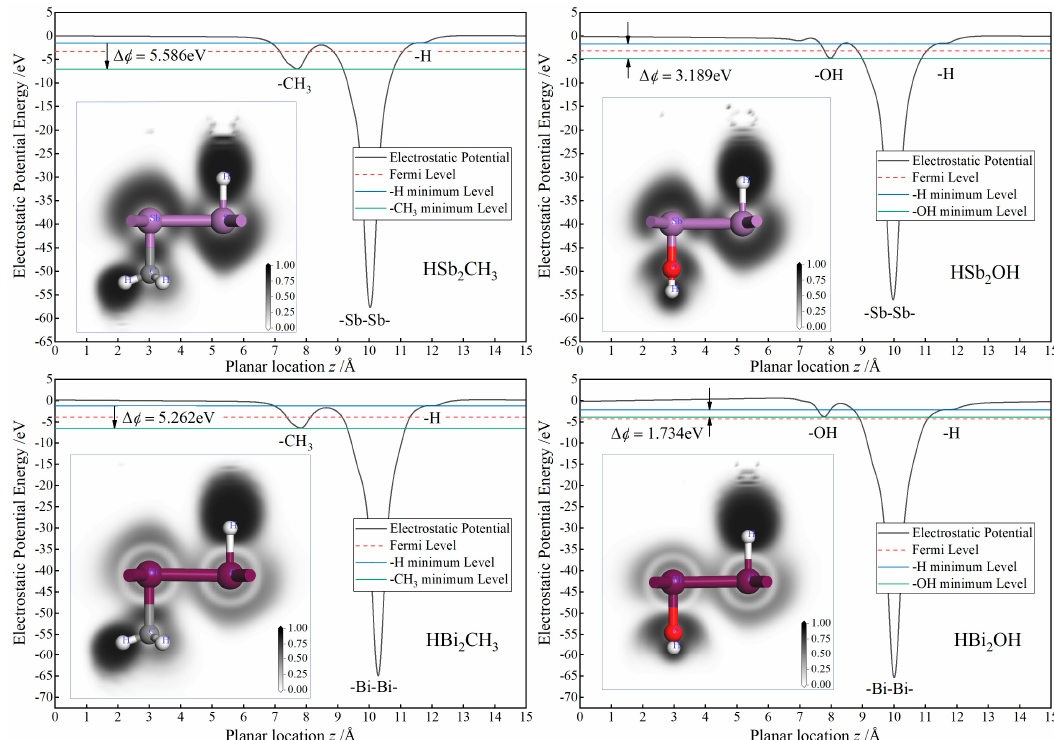
Figure 3. Internal potential gradient and bonding characteristics of the Janus Sb and Bi monolayers: mean electrostatic potential as a function of the planar position, with the inserted panels showing the electron localization function contoured on the normal plane crossing both Sb or Bi and C or O atomic centers.